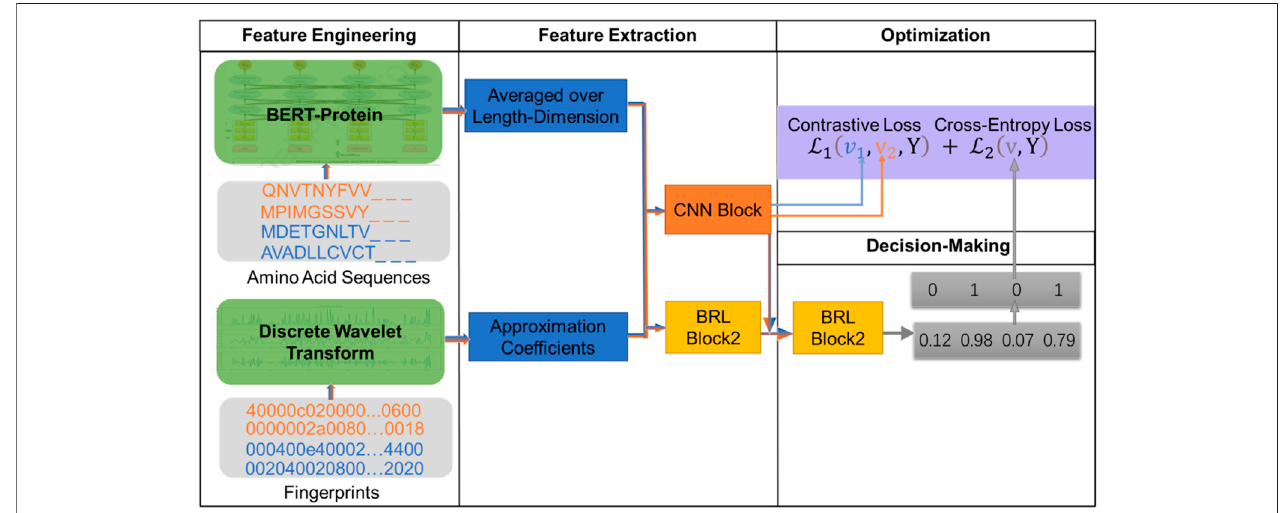
FIGURE 1 | Flowchart of the DTI-BERT model.